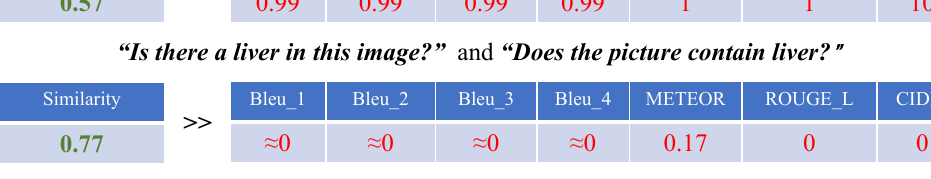
Figure 3. Example of the failure of traditional evaluation metrics. Although the previous indicators can evaluate the results to some extent, there are still many